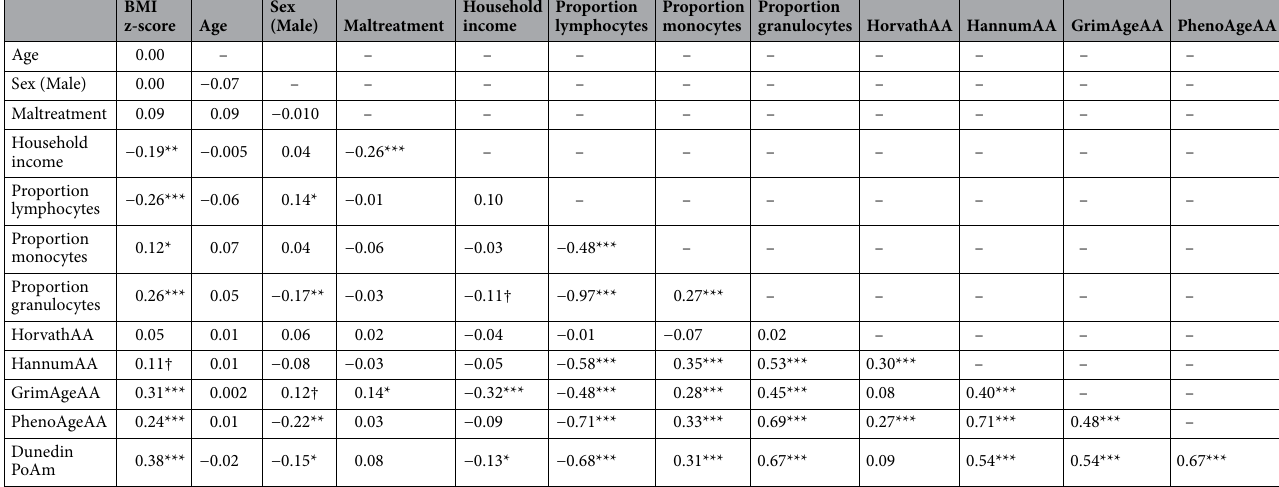
Table 2. Correlations among outcomes and covariates. † P < .10, * P < .05, ** P < .01, *** P <